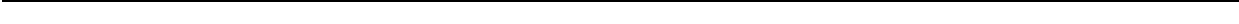
Figure 6 | Functional assessment of fopMK in vitro platelets. ( a ) Adhesion to fibrinogen of fopMK and cbMK in vitro platelets upon combined TRAP þ ADP stimulation compared to blood platelets using a flow cytometry bead based assay. Percentages of adhesion on BSA or fibrinogen-coated beads are shown (mean ± s.e.m., n ¼ 4, 4, 2 for blood, fopMK and cbMK respectively; ** P o 0.01 versus blood by two-tail t -test). ( b ) Representative pictures from in vitro s preading assay. Washed platelets were sown on fibrinogen-coated slides, incubated for 45 min at 37 (cid:2) C and immunostained for alpha-tubulin (TUBA) and F-actin (scale bars, 10 m m). ( c ) Aggregation of fopMK platelets upon agonists stimulation was tested both with and compared with blood platelets using a flow cytometry-based assay: representative dot plots are shown. ( d ) Percentages of aggregation from Calcein-AM þ live platelets upon stimulation are shown for blood and fopMK platelets reactions (2 (cid:2) 10 7 platelets per ml; mean ± s.e.m., n ¼ 7 for each reaction group; no statistical difference versus blood at P o 0.01 by two-tail t -test). ( e ) Associated delta-aggregation defined as ((% ADP þ TRAP aggregation)—(% no agonist aggregation)) for the different reaction groups (mean ± s.e.m., n ¼ 7; P values by two-tail t -test versus blood indicated). ( f ) Thrombus formation in vitro under arterial shear stress. The participation of Calcein-AM live platelets spiked into human blood (at 1 (cid:2) 10 7 per ml) is shown per 100 m m 2 thrombus area. Normal or thrombocytopenic blood ( 4 150 (cid:2) 10 9 and o 50 (cid:2) 10 9 l (cid:3) 1 respectively) was used as recipient. Spiked platelets were sourced from day-8 concentrate unit (blood) or from fopMK platelets (iPSC#1 and #5; n 4 30 analysed thrombi per group; P values by two-tail t -test versus blood indicated). ( g ) Representative pictures from in vitro thrombus formation assays. Thrombi identified using bright field images are delineated and Calcein-AM platelets fluorescing in green; in vitro platelets Calcein-AM labelling is intrinsically dimmer than donor-derived platelets (Supplementary Fig. 5b). Scale bar, 50 m m. ( h ) Thrombus formation in vivo by laser injury of an arteriole in the cremaster muscle of NSG mice and intravital confocal microscopy. The incorporation of human Calcein-AM-labelled platelets (50 million transfused per mouse) to mouse thrombi is shown per 100 m m 2 thrombus area at T_max (thrombus maximum size). Mean values ± s.e.m. and P values by two-tail t -test versus donor platelets are shown ( n ¼ 16/4/8 thrombi analysed for blood, fopMK#1 and #5 platelets respectively). ( i ) Representative snapshots of Calcein-AM þ human platelets incorporated to mouse thrombus (scale bar 10 m